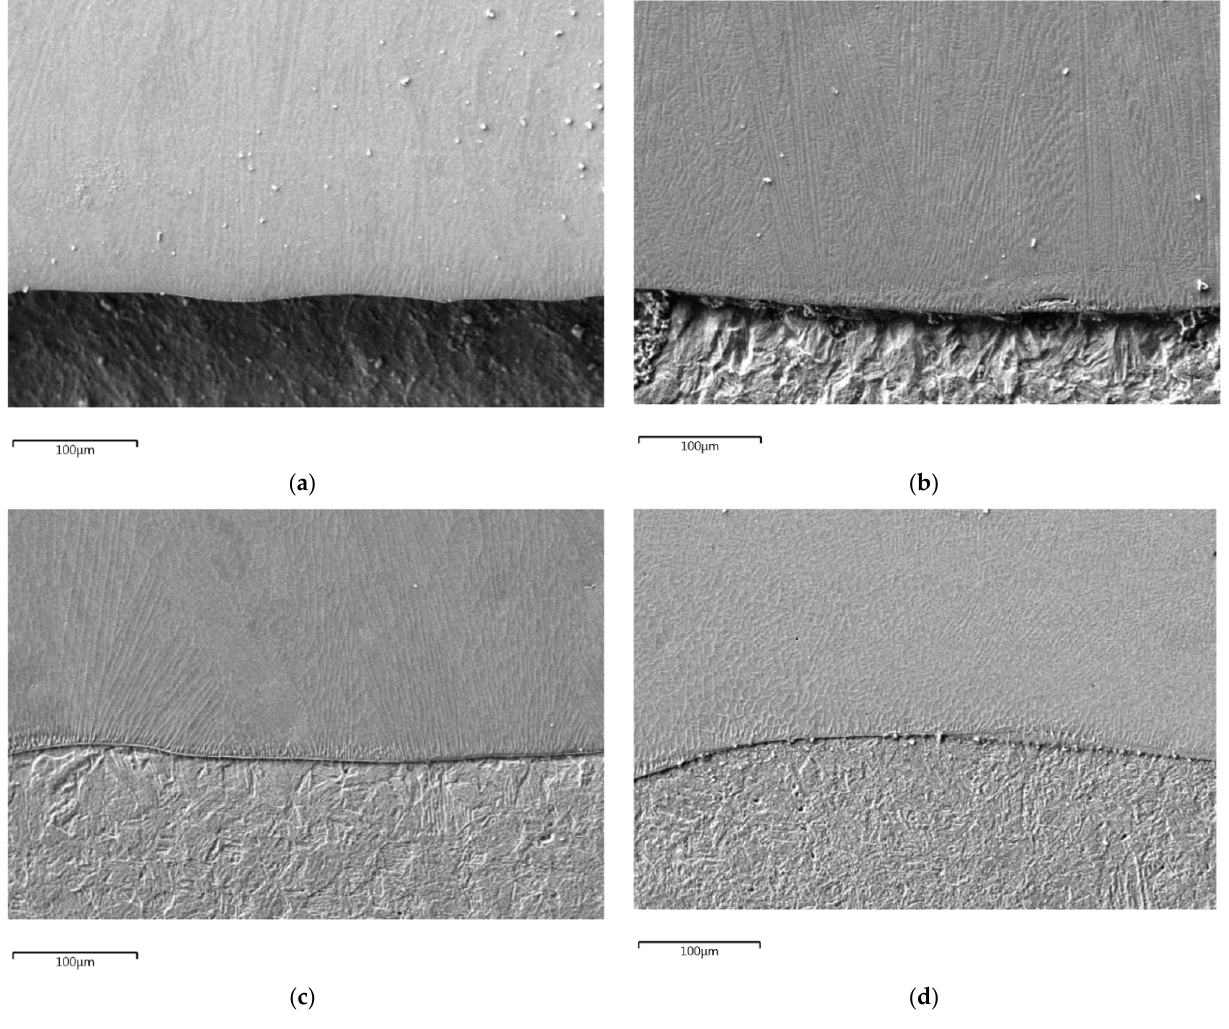
Figure 9. SEM microstructure of arc deposited coatings ( a ) Inconel 625; ( b ) Inconel 718; ( c ) Alloy 33; ( d ) Stellite 6. Table 4. Chemical composition of nominal filler material specified at standards and chemical compo- sition measured by means of EDX in a cross-section of cladded coating, in